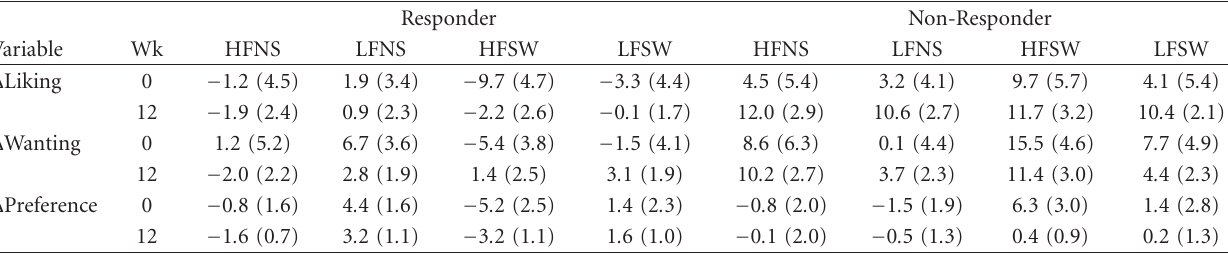
Table 3: Acute changes in hedonic evaluation of food measured before and after a single bout of exercise at week 0 and week 12 of a supervised daily exercise